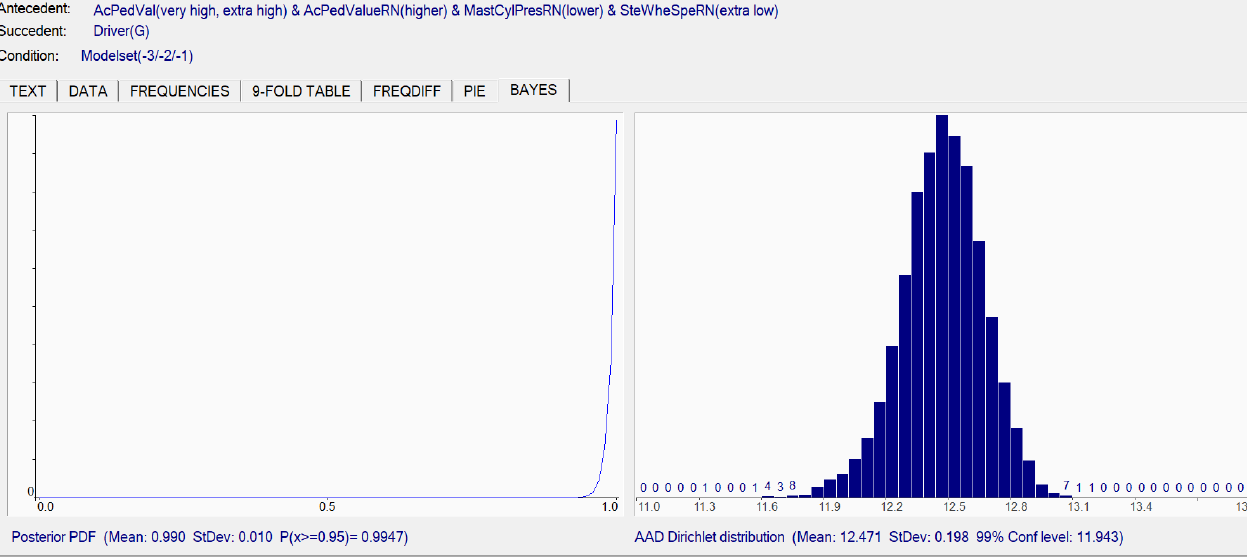
Figure 4. Bayesian theory-based interpretation of the statistical significance of the hypothesis G: model.